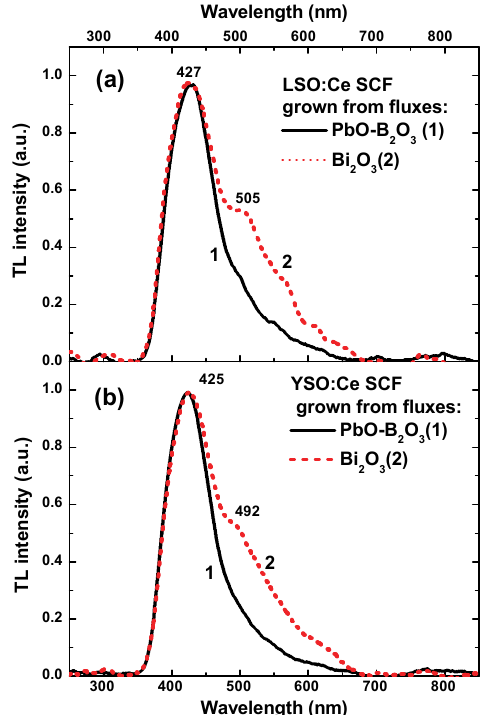
Figure 3. Normalized emission spectra of ( a ) LSO:Ce and ( b ) YSO:Ce, prepared with PbO-B 2 O 3 (1) and Bi 2 O 3 (2) fluxes, irradiated with alpha particles (6.95 × 10 9 cm − 2 ). Emission spectra were integrated over the whole temperature range. TL: thermoluminescence.